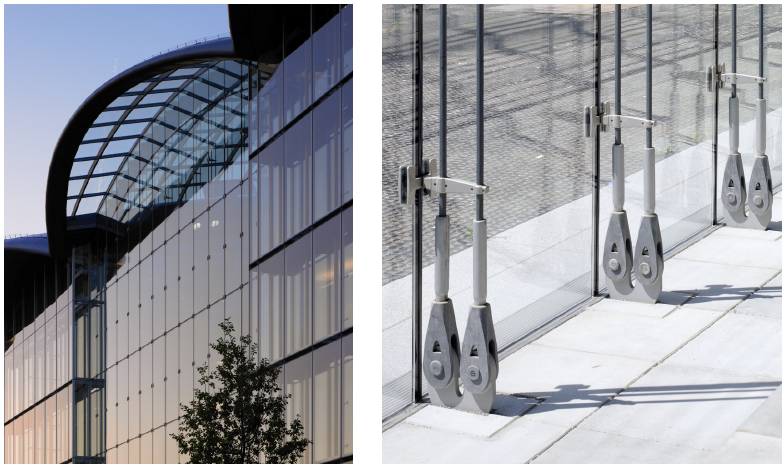
Figure 6: Lufthansa Aviation Center, Frankfurt